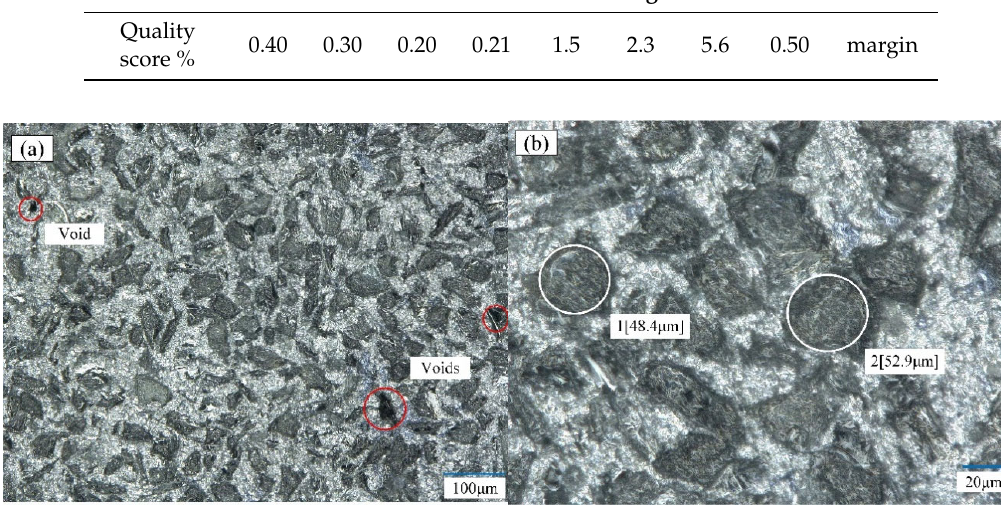
Figure 6. The observation of the surface morphology of the SiCp/Al composite ; ( a ) Scanning electron microscopy overall surface topography; ( b ) Sic particle size.